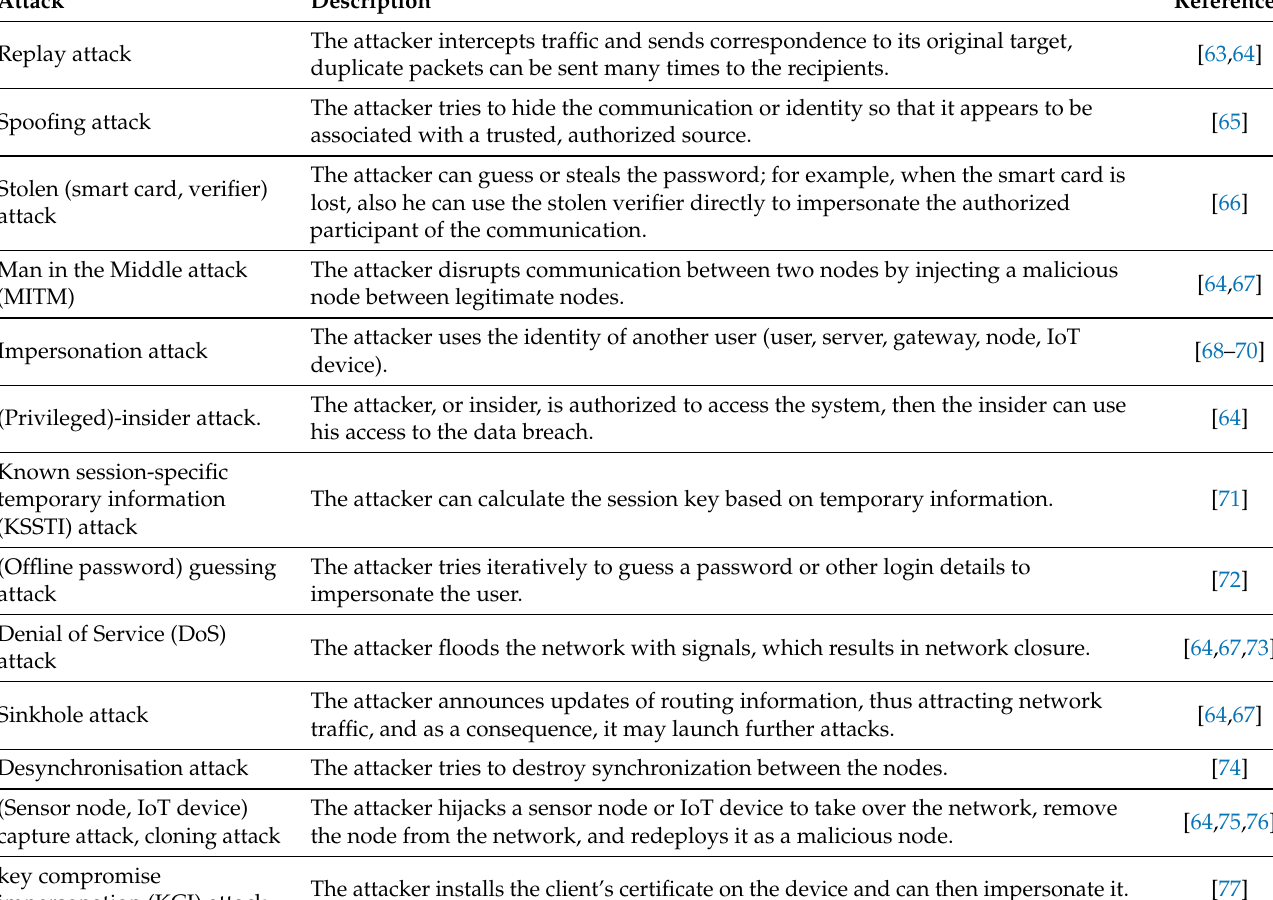
Table 1. Typical attacks in